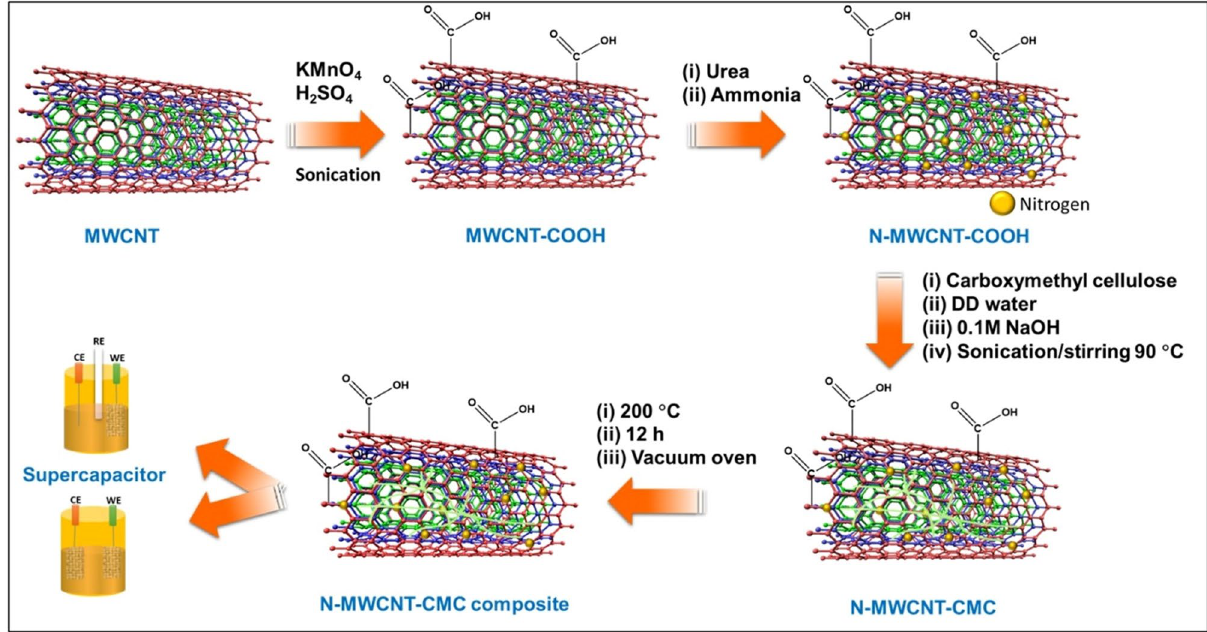
Figure 1. Schematic illustration of the N-MWCN/CMC